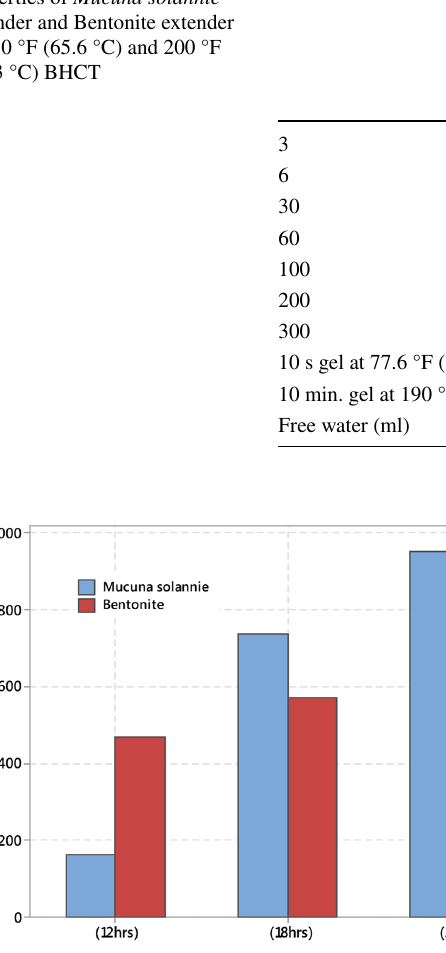
Table 4 Slurry rheological properties of Mucuna solannie extender and Bentonite extender at 150 °F (65.6 °C) and 200 °F